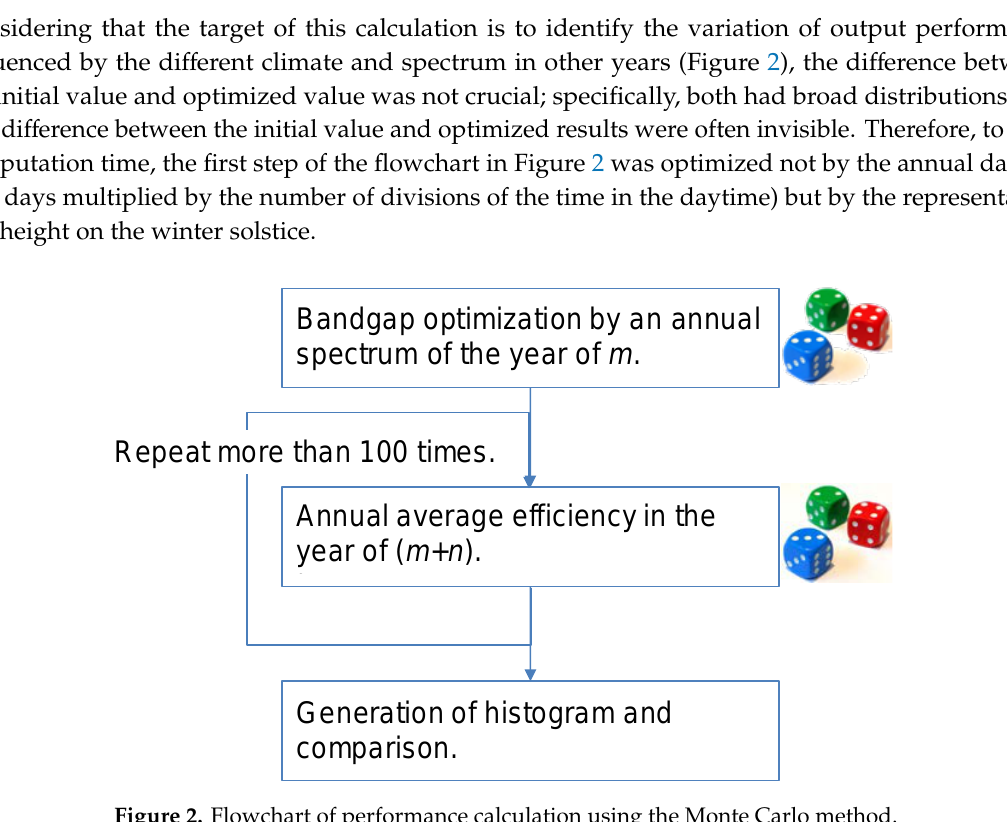
Figure 2. Flowchart of performance calculation using the Monte Carlo method.